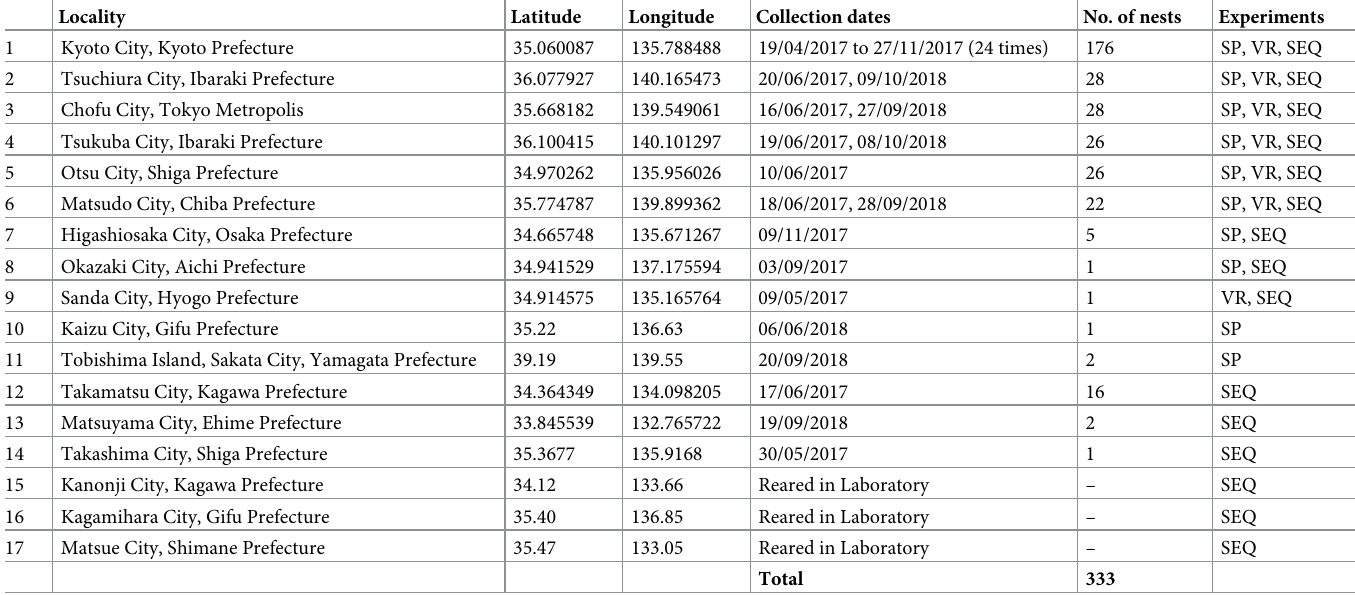
Table 1. Sampling sites of Monomorium triviale populations and experiments performed.